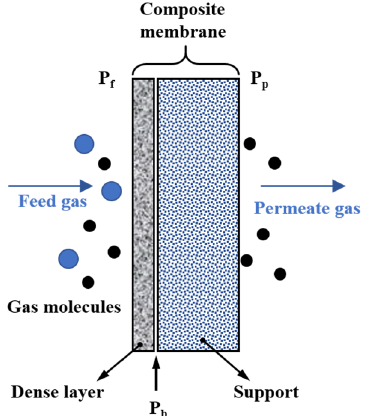
Figure 1. The transport process of gas molecules through a composite membrane.